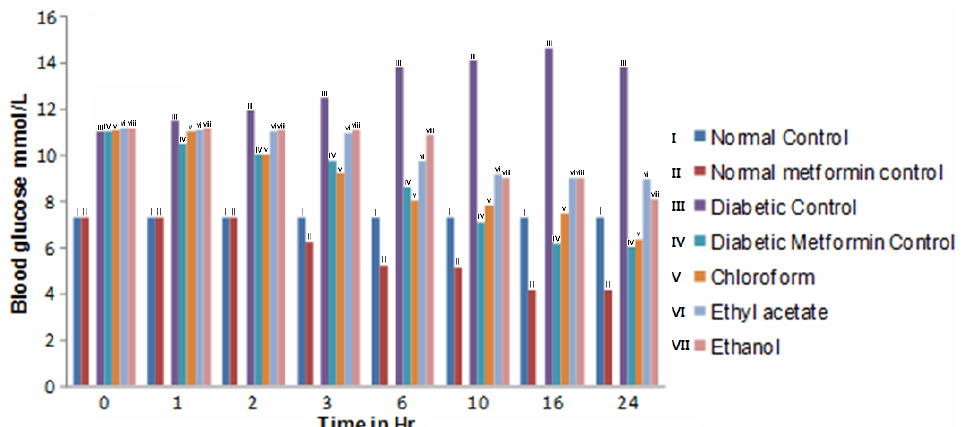
Figure 2. Effect of various fractions of Hydrolea zeylanica on blood glucose level in diabetic rats on one treatment